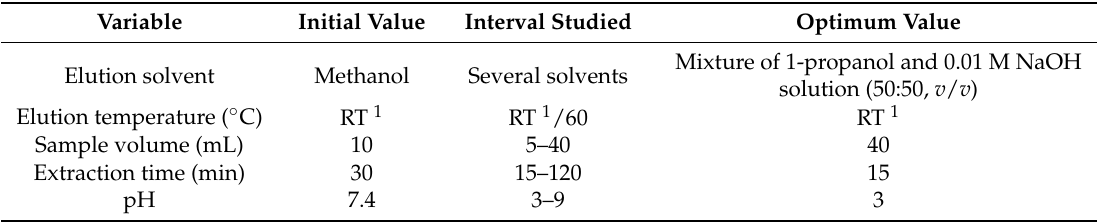
Table 1. A list of the variables studied in extraction optimization.